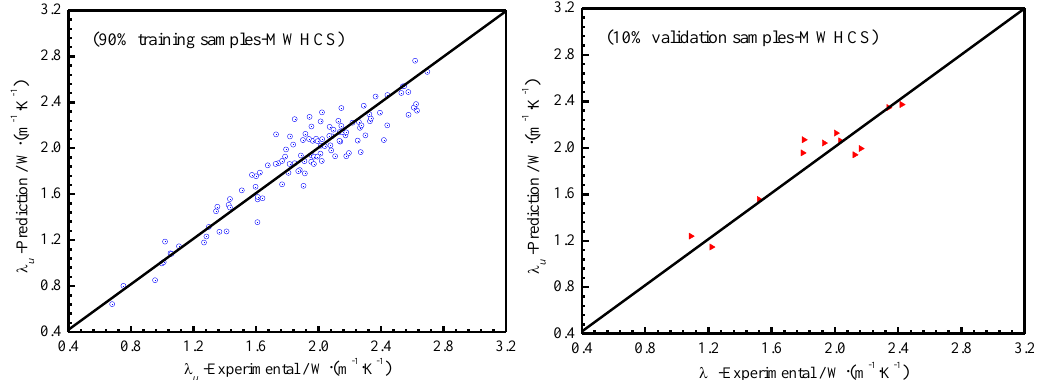
Figure 12. Predictive values of unfrozen MWHCS using RBF neural network method.